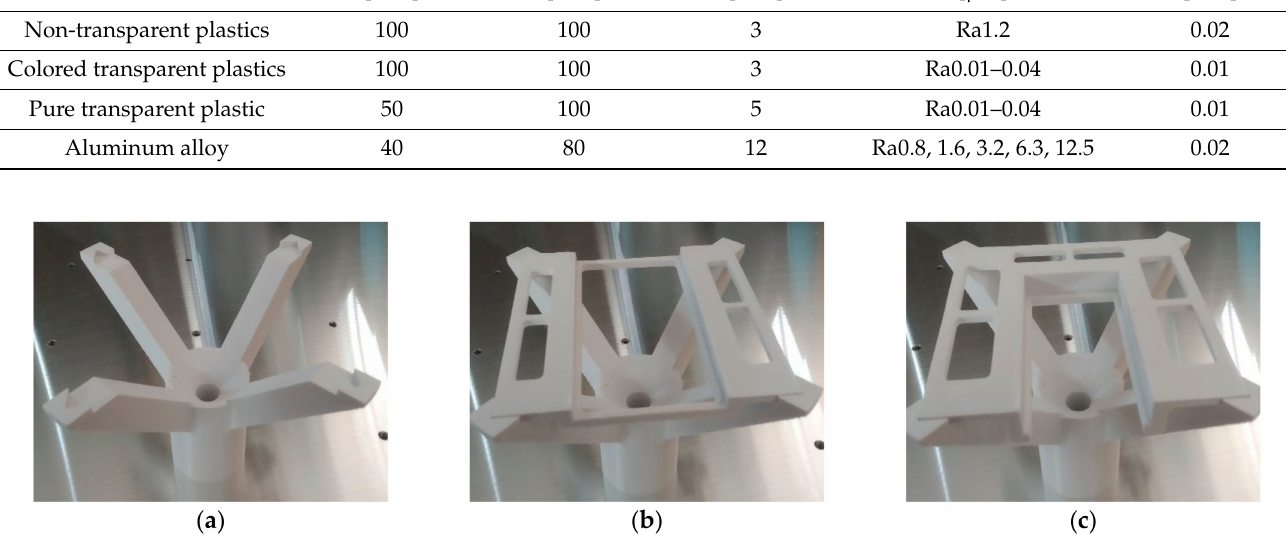
Figure 7. Plastic holder for scanning samples of thickness: ( a ) 3; ( b ) 5; ( c ) 12